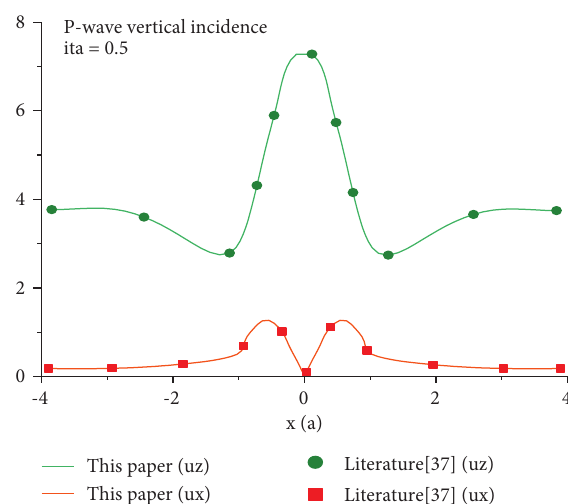
Figure 7: P -wave vertical incidence surface displacement am- plitude ( Y � 0 and Z � 0).